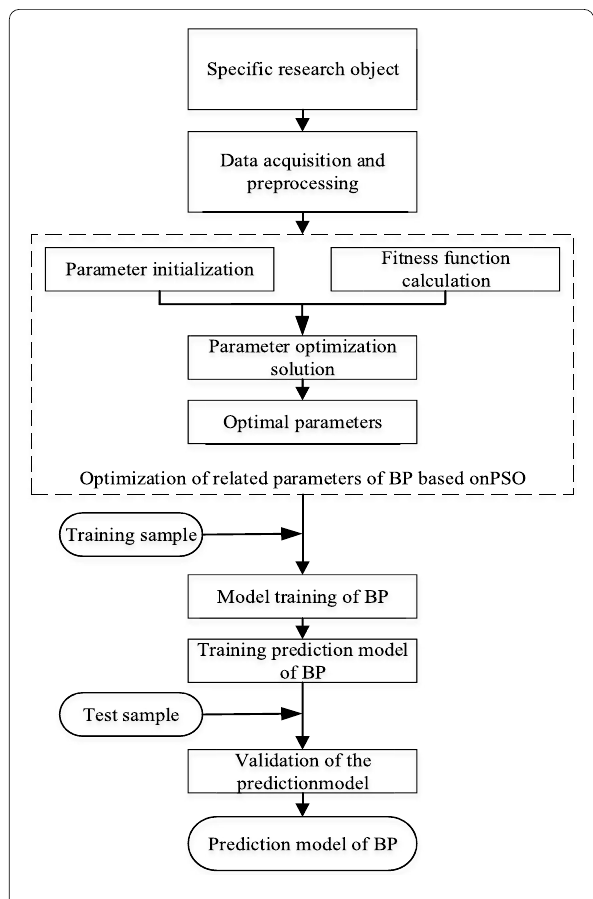
Figure 3 PSO-BP network modeling